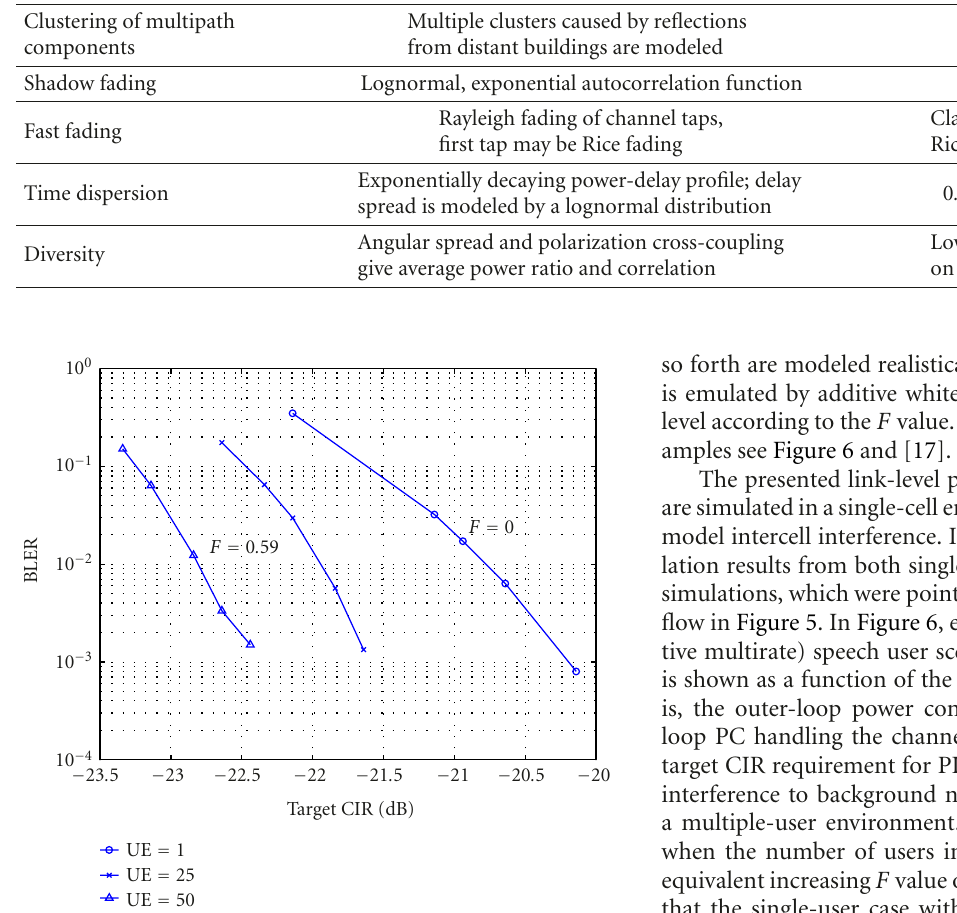
Figure 6: Link-level simulations of PIC performance. Multiple users are simulated in a single cell with intercell interference mod- eled as AWGN with the power F times the intracell interference power. Note that UE = 1 corresponds to conventional RAKE per- formance in a single